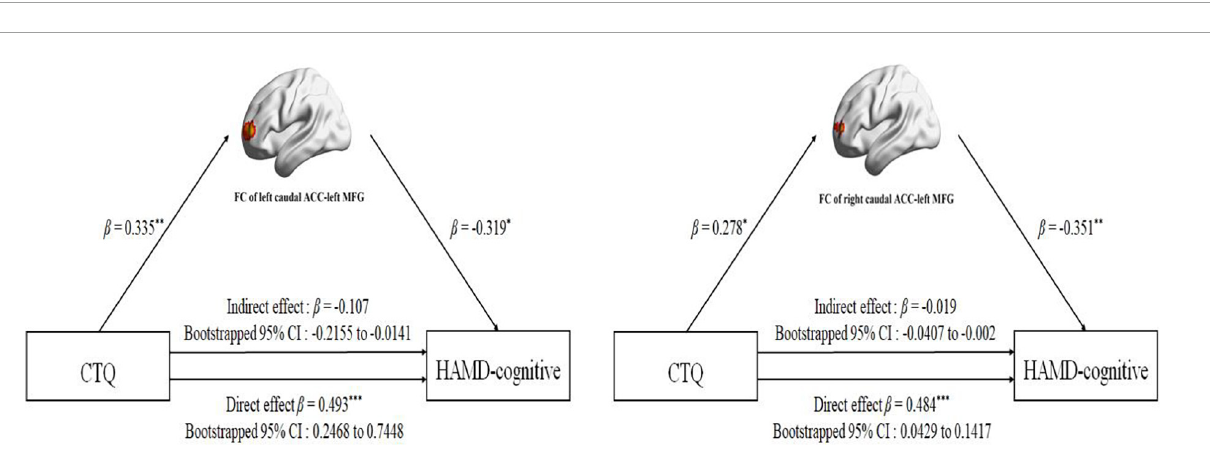
FIGURE5 Mediation analysis for effect of the FC between bilateral caudal ACC and left MFG on the relationship between childhood traumatic (CTQ total score) and HAMD-cognitive disturbance factor (HAMD-cognitive score) in MDD group. For the path coefficient: ∗ p < 0.05; ∗∗ p < 0.01; ∗∗∗ p < 0.001. CTQ, Childhood Trauma Questionnaire; HAMD-cognitive, Hamilton Depression Scale-cognitive disturbance factor; FC, functional connectivity; ACC, anterior cingulate cortex; MFG, middle frontal gyrus; β , standardized regression coefficient; Cl, confidence interval.